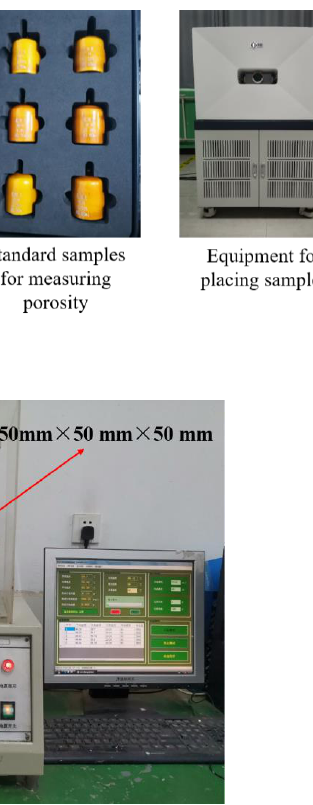
Figure 7. Thermal conductivity parameter test. Table 1. Thermal physics parameters of the surrounding rock.